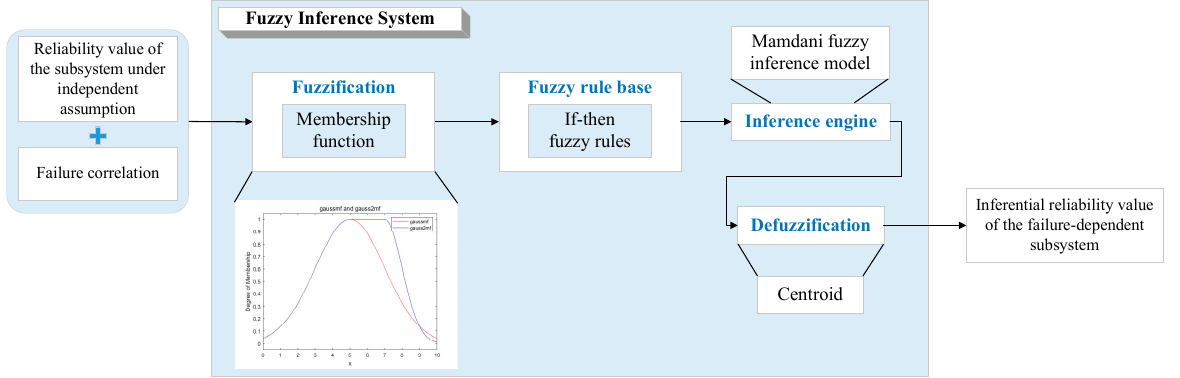
Figure 2. Fuzzy inference system for the evaluation of subsystem reliability.